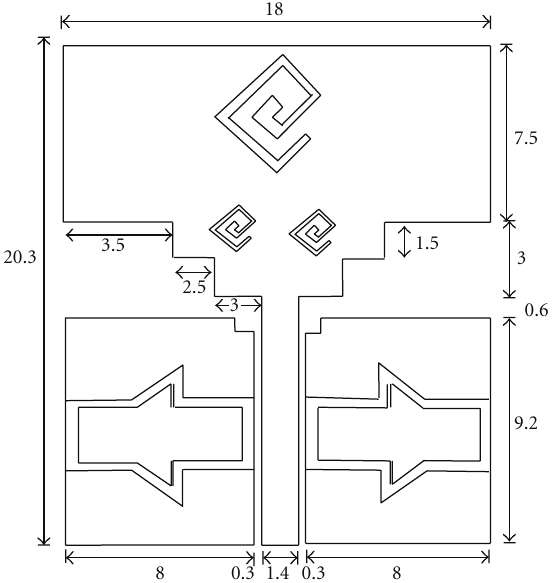
Figure 1: Proposed UWB antenna with band stop filters.